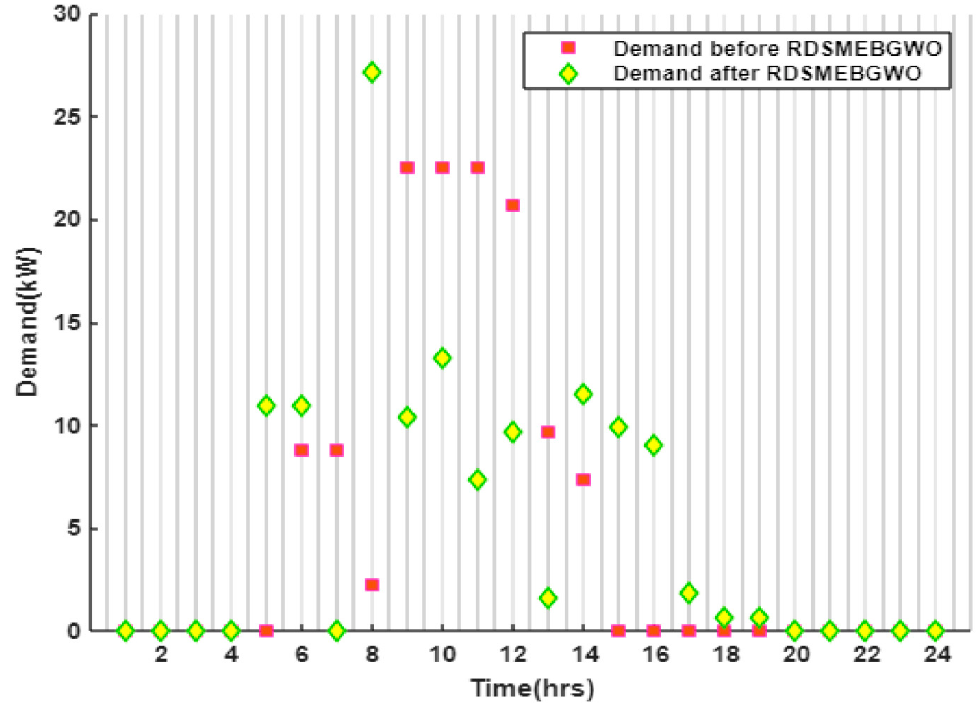
Figure 9. Demand for user comfort loads before and after RDSMEBGWO.